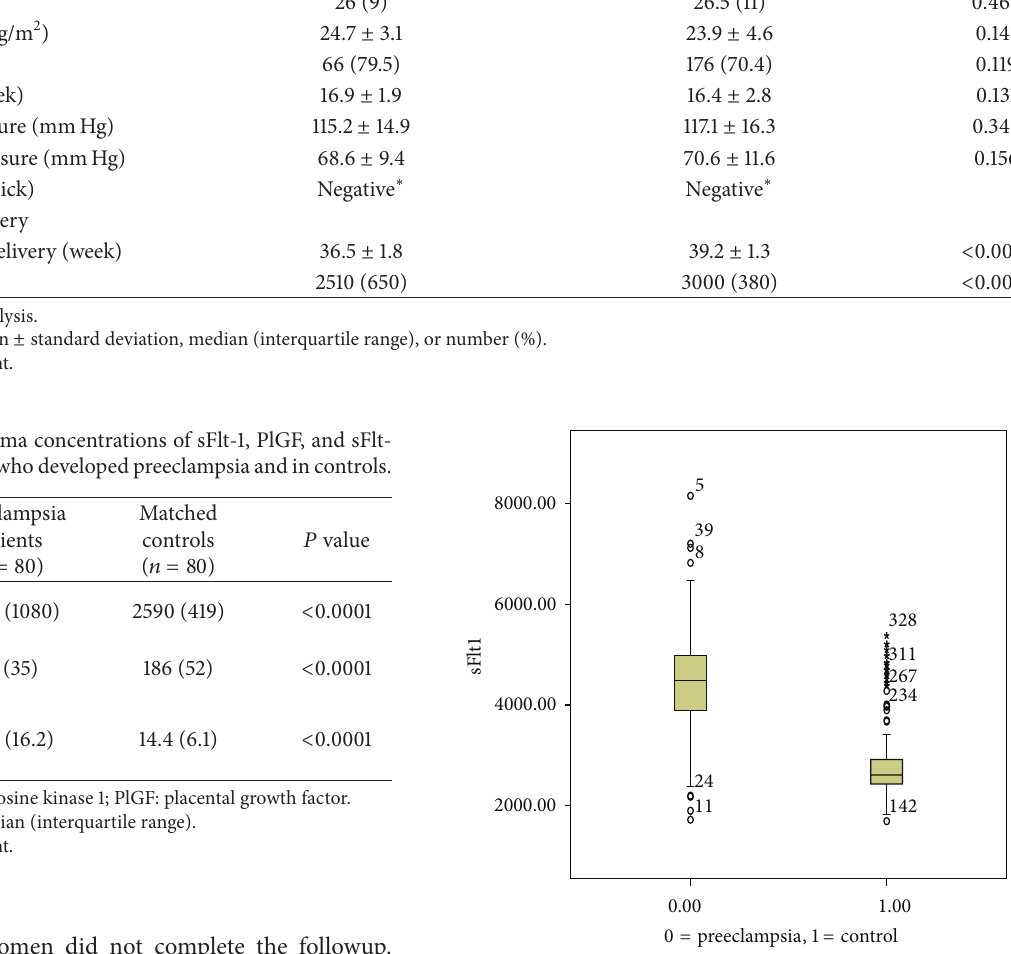
(interquartile range) plasma level of sFlt-1 was significantly higher in the case group compared to women in the control group (4490 (1080) versus 2590 (419), resp., 𝑃 < 0.0001 ) (Figure 1). In contrast, median plasma level of maternal PlGF was significantly lower in women of the case group compared to those in the control group (98 (35) versus 186 (52), resp., 𝑃 < 0.0001 ) (Figure 2). In women with preeclampsia, the median sFlt-1/PlGF ratio was significantly higher compared to the control group (44.8 (16.2) versus 14.4 (6.1), resp., 𝑃 < 0.0001 ) (Figure 3). In Table 3, serum levels of sFlt-1, PlGF, and sFlt-1/PlGF ratio were compared according to the gestational age at delivery (term and preterm preeclampsia). Serum sFlt-1